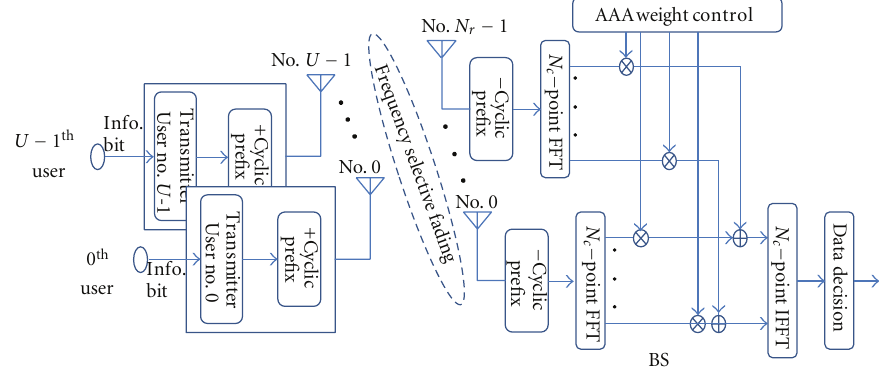
Figure 4: FDAAA uplink